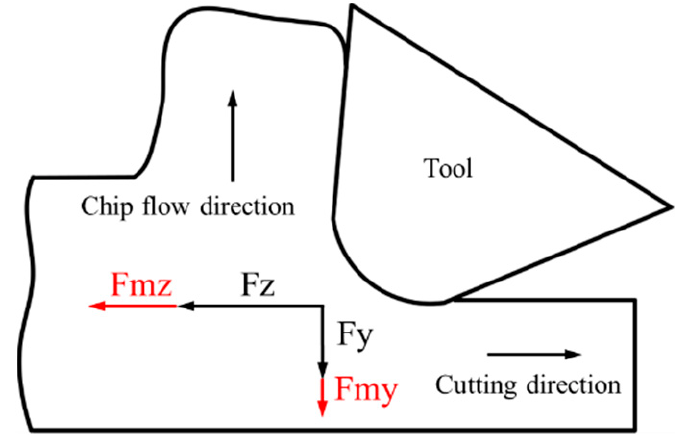
Figure 8. The induced Lorentz force.